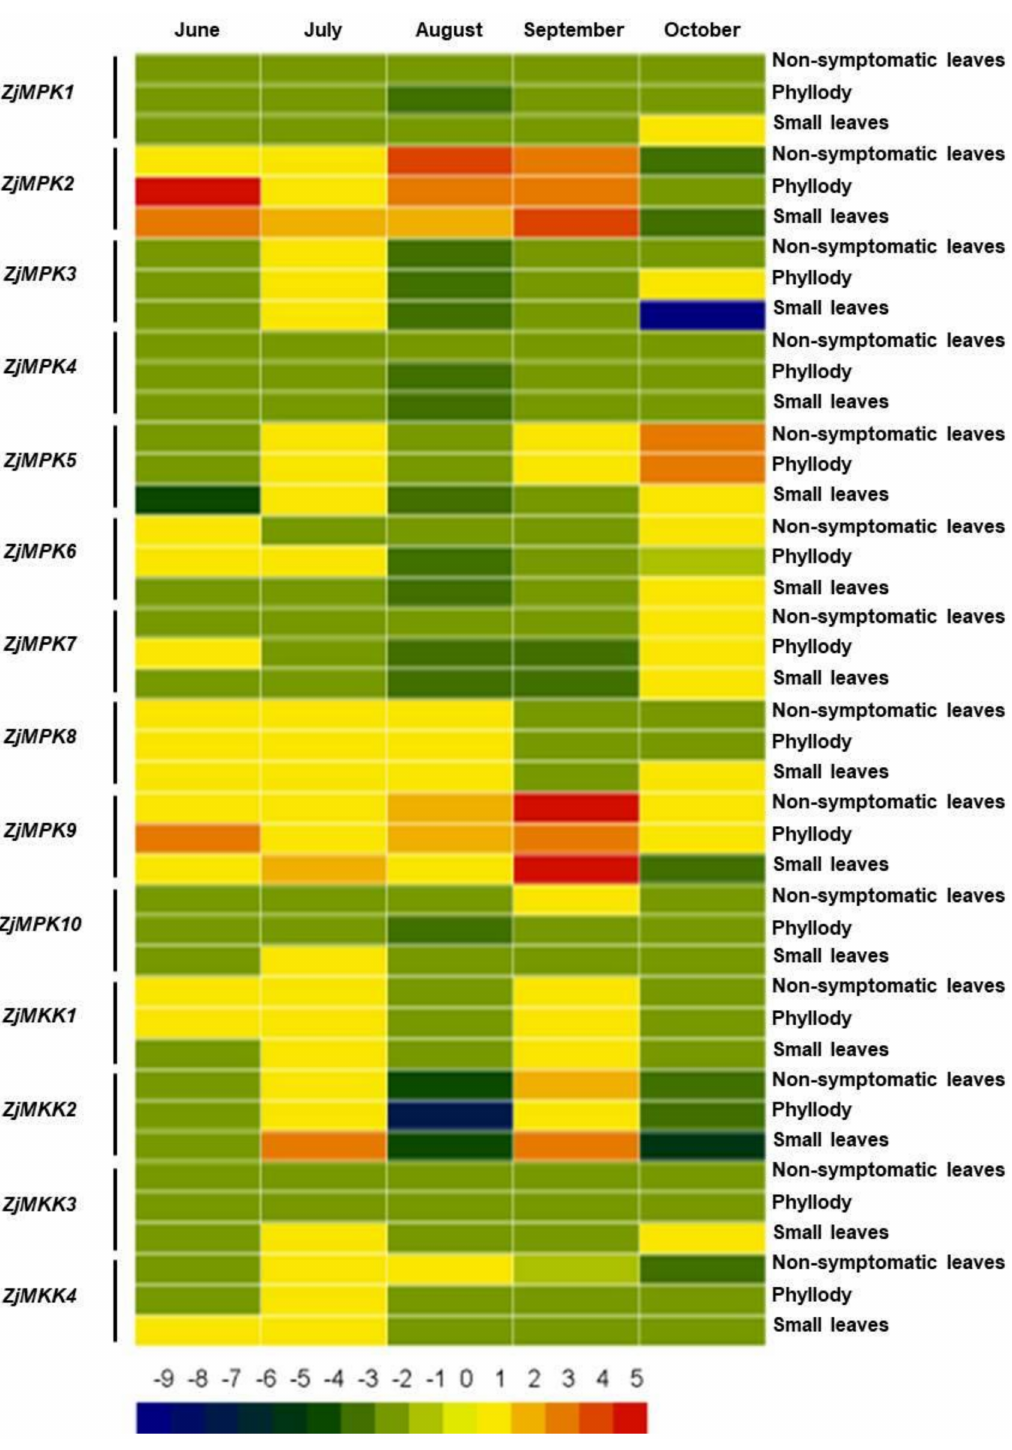
Figure 2. The expression profiles of ZjMPK and ZjMKK genes in tissues showing di ff erent JWB disease symptoms. The heatmap was generated by Heml 1.0 using expression fold-change. Up-regulated genes were colored in red, down-regulated genes were colored in blue (color code in the